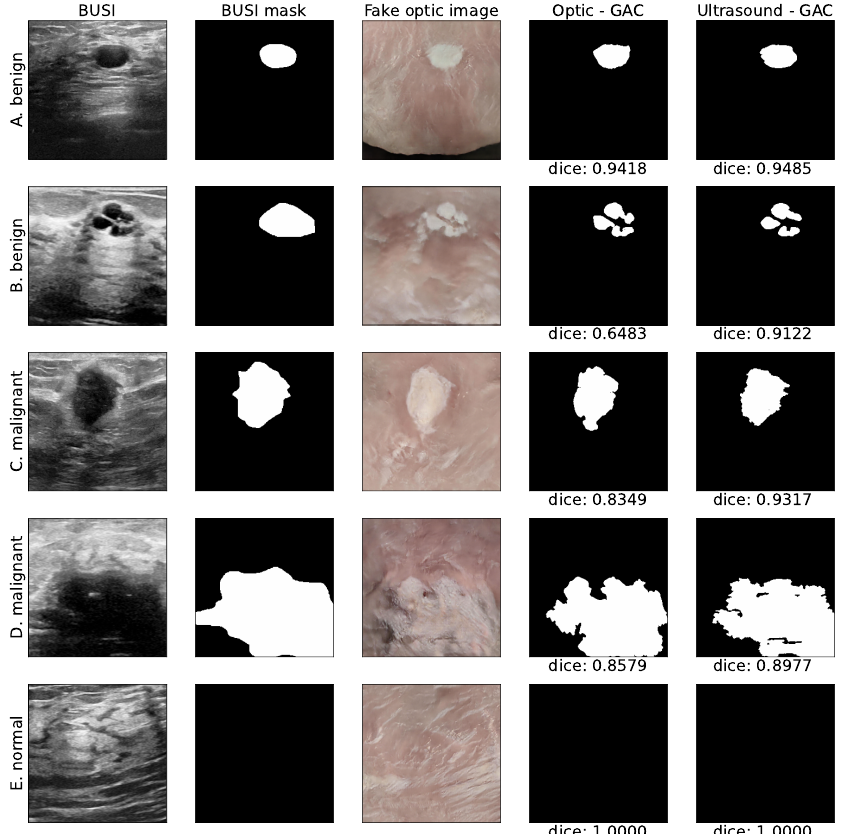
Figure 2. (1st column) Examples of the BUSI images. (2nd column) BUSI masks. (3rd column) The model-generated pseudo anatomical images. (4th column) The corresponding segmented masks obtained by MorphGAC for the pseudo anatomical images and for the original ultrasound images (5th column), with the corresponding Dice scores. The rows correspond to: ( A ) benign, ( B ) benign, ( C ) malignant, ( D ) malignant, and ( E ) normal. As can be noted, the pseudo anatomical images are more natural to comprehend, and the tumors are better